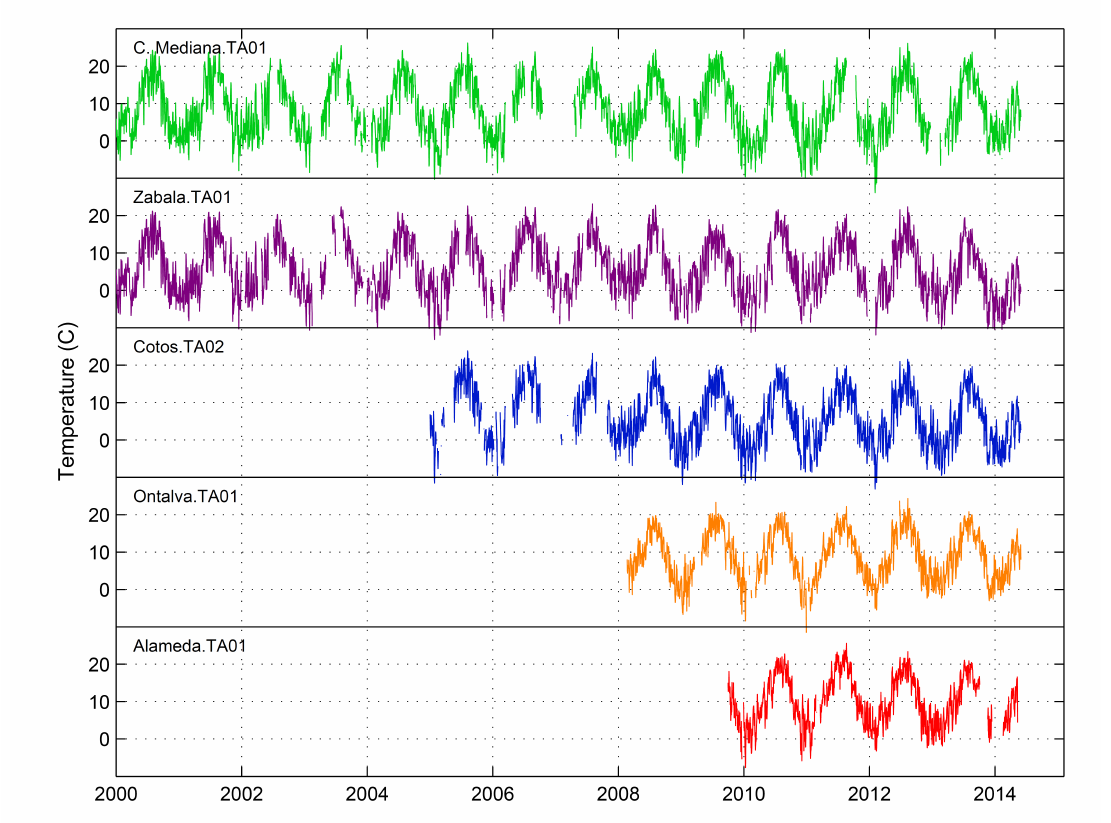
Figure 3. Time series of daily air temperature at the five sites from 2000 to